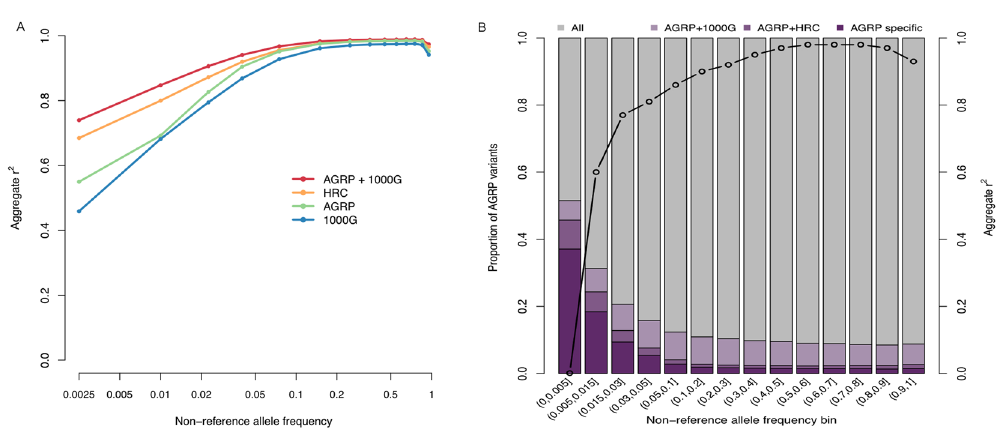
Figure 2. Imputation of shared and AGRP-specific variants. ( A ) Imputation accuracy (aggregate squared Pearson correlation coefficient, r 2 ), across various reference panel configurations. The x-axis (log scale) shows the 1000G EUR (non-refernce) allele frequency of the variants being imputed. ( B ) The stacked bars show proportions of variants found in AGRP (left y-axis) that were also shared by various reference panels across a range of (non-reference) allele frequency bins in the AGRP. The embedded black line shows the imputation accuracy of AGRP-specific variants (right y-axis) when the merged AGRP/1000G reference panel was